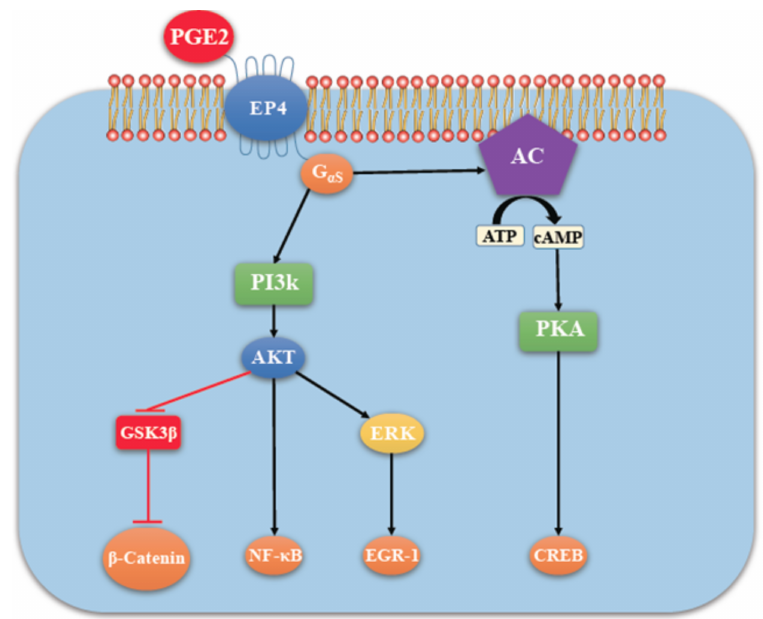
Figure 5. EP4 mediated signaling (in addition to PKA activation) not shared by EP2 (adapted with kind permission from O’callaghan, G.; Houston, A.; 2015; reference [13]). There is non-canonical activation of the PI3K-Akt and ERK pathways. Akt, also called protein kinase B (PKB) promotes cell survival by activating the transcription factor NF- κ B. ERK is primarily a promoter of cell proliferation and migration. Cell proliferation depends on the ERK mediated activation of the transcription factor EGR-1.